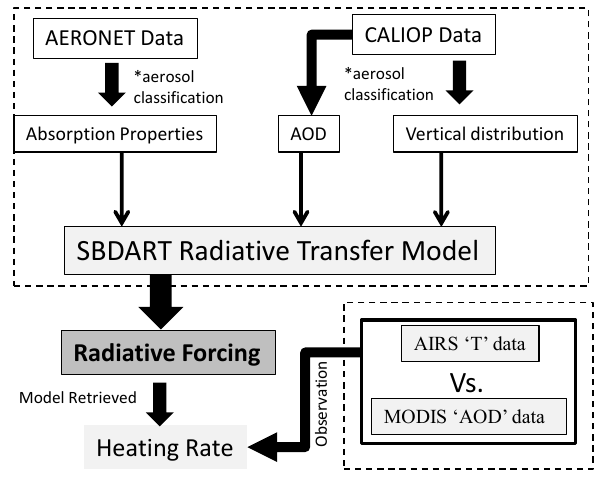
Figure 2. Flow chart of the methodology. The explanations are given in text. *Aerosol classification: aerosols are classified as dust, polluted dust (mixed aerosol), and polluted continental (pollution) classes. All optical and microphysical properties are derived for each class of